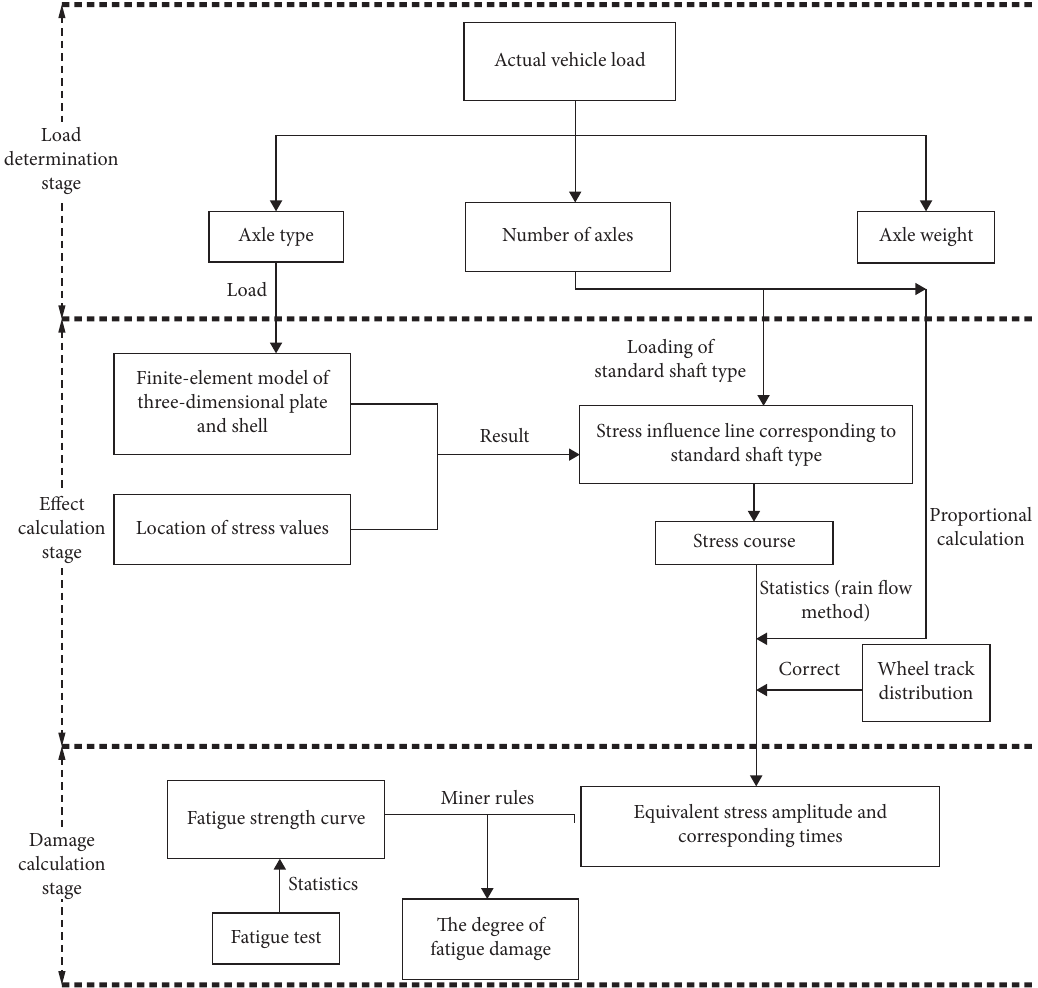
Figure 1: Fatigue damage assessment procedure for the bridge